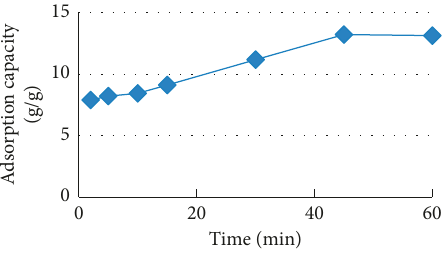
Figure 2: Effect of sorption